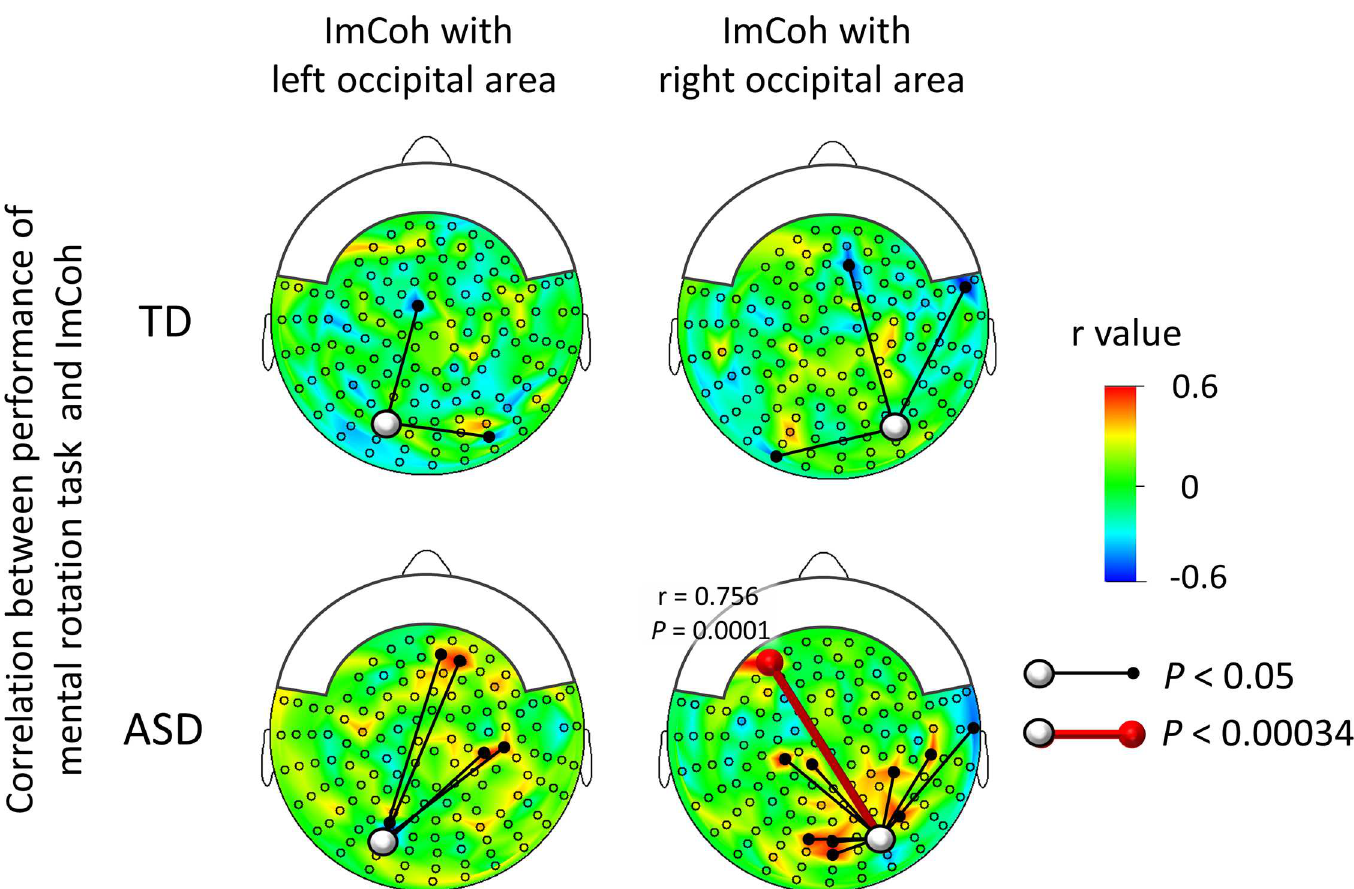
Fig 4. Correlation betweenperformance of a mentalrotation task and ImCoh. In TD children(upperrow), therewere no significantcorrelations for any sensor pair (i.e., alpha < 0.00034).In AS children(lower row), therewas a significant positive correlation for one sensor pair (redlines);rightoccipital–left frontalpair (r = 0.756,P = 0.0001).ImCoh:imaginary